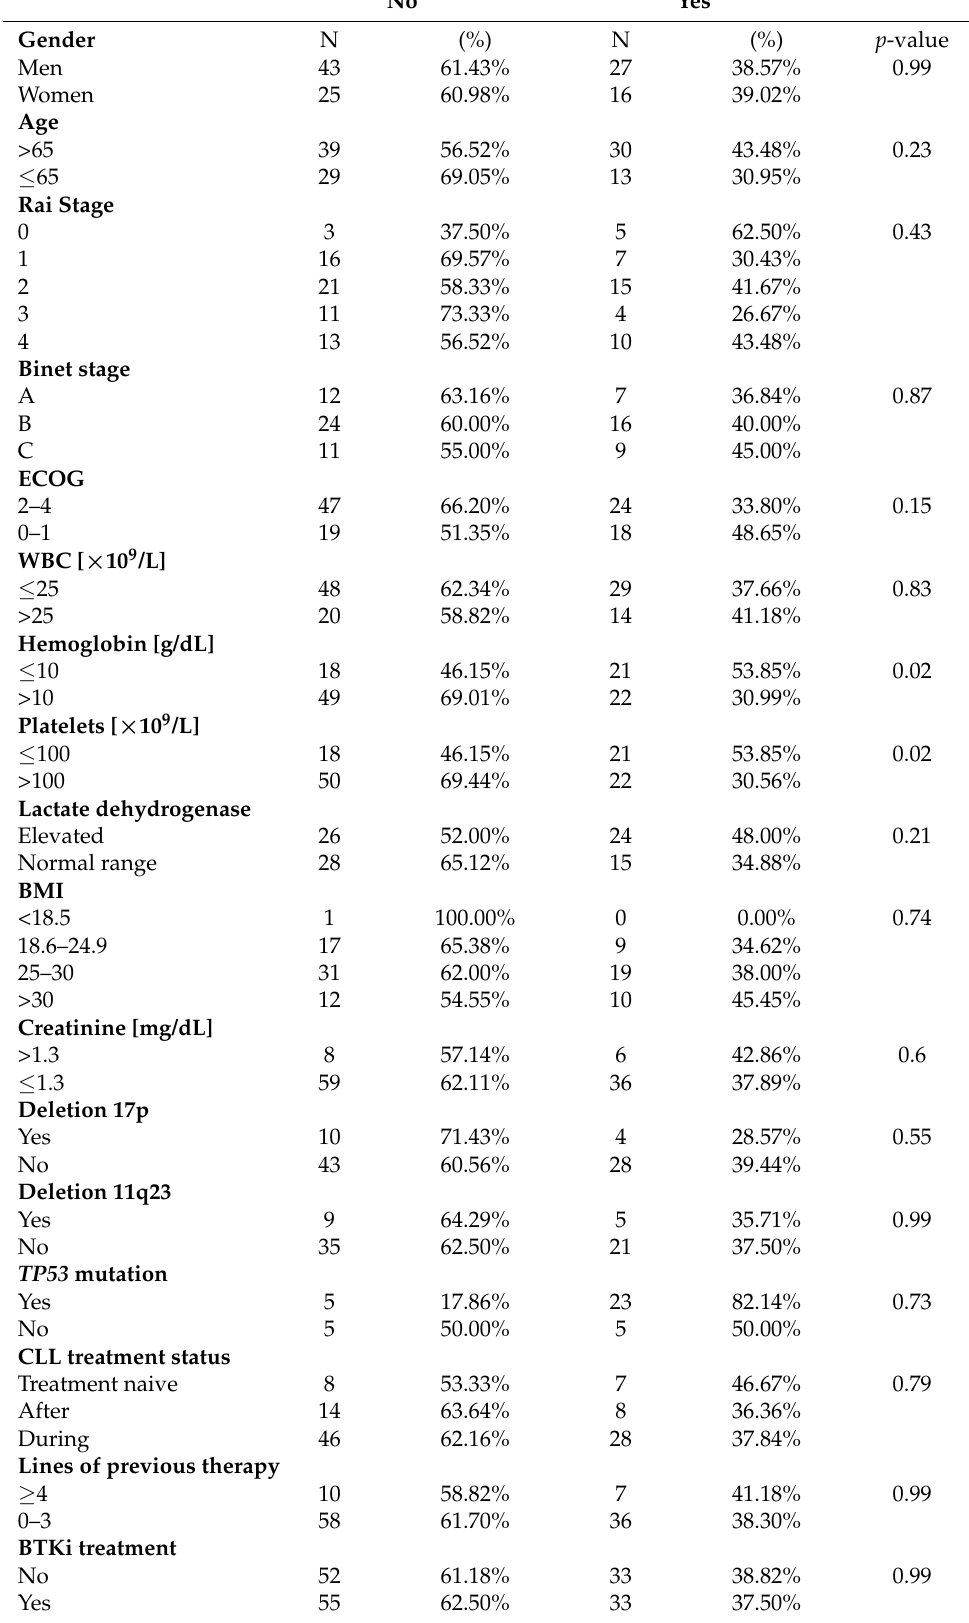
Table 2. Factors associated with increased risk of death in the hospitalized